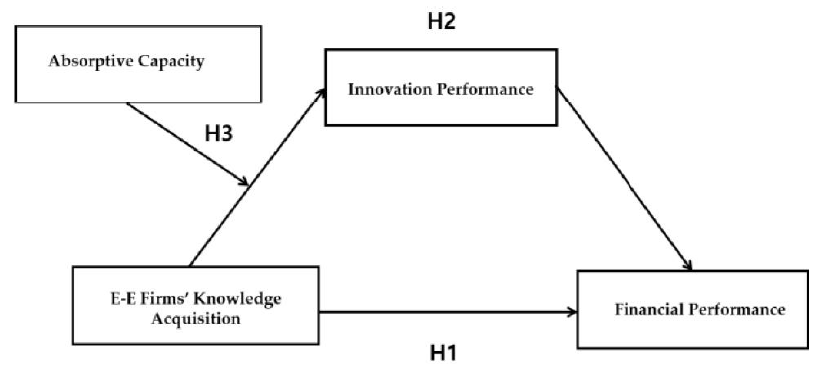
Figure 1. Research model